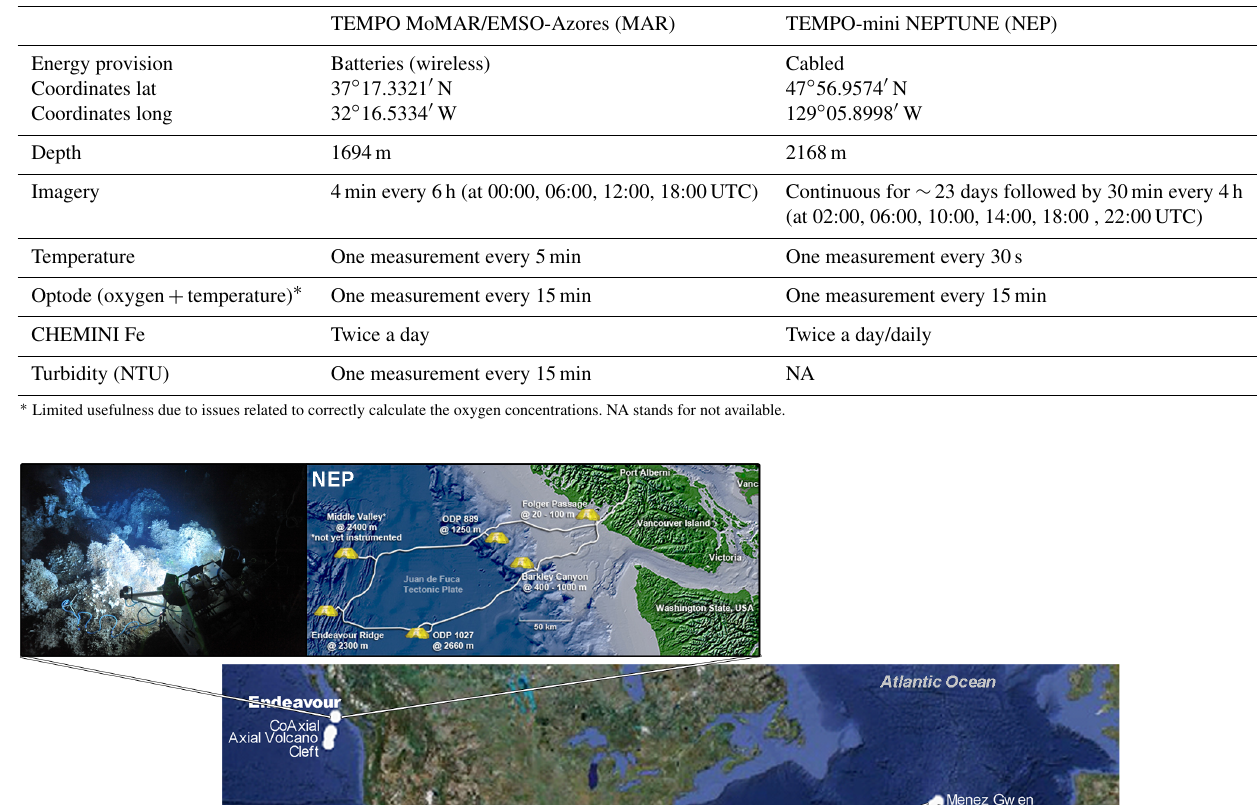
Table 1. Overview of the location, data recorded and the recording resolutions of all variables of the two observatories on the NEP and MAR.